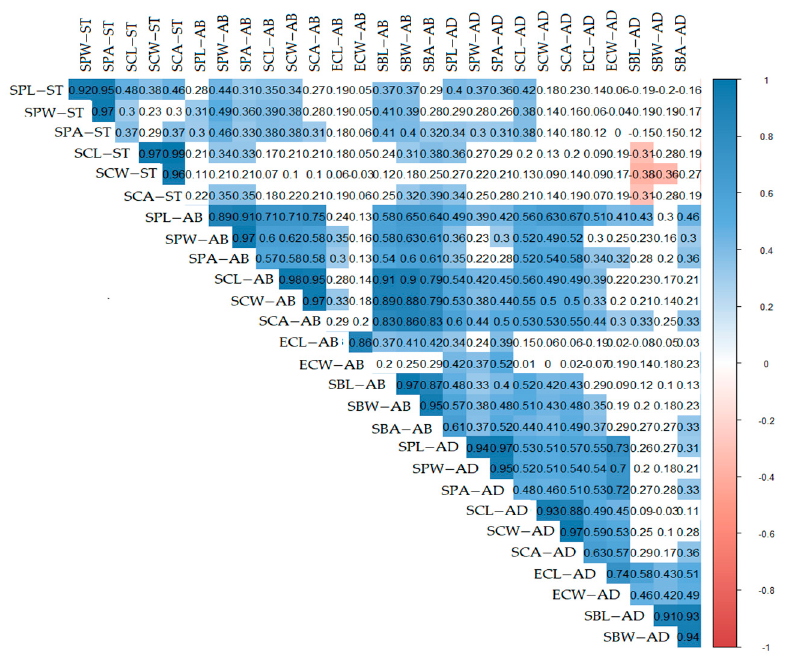
Figure 7. Correlogram between quantitative traits of Silene leucophylla and Silene schimperiana . Positive and negative correlations are displayed in blue and red color, respectively. Correlation coefficients are proportional to color intensity.